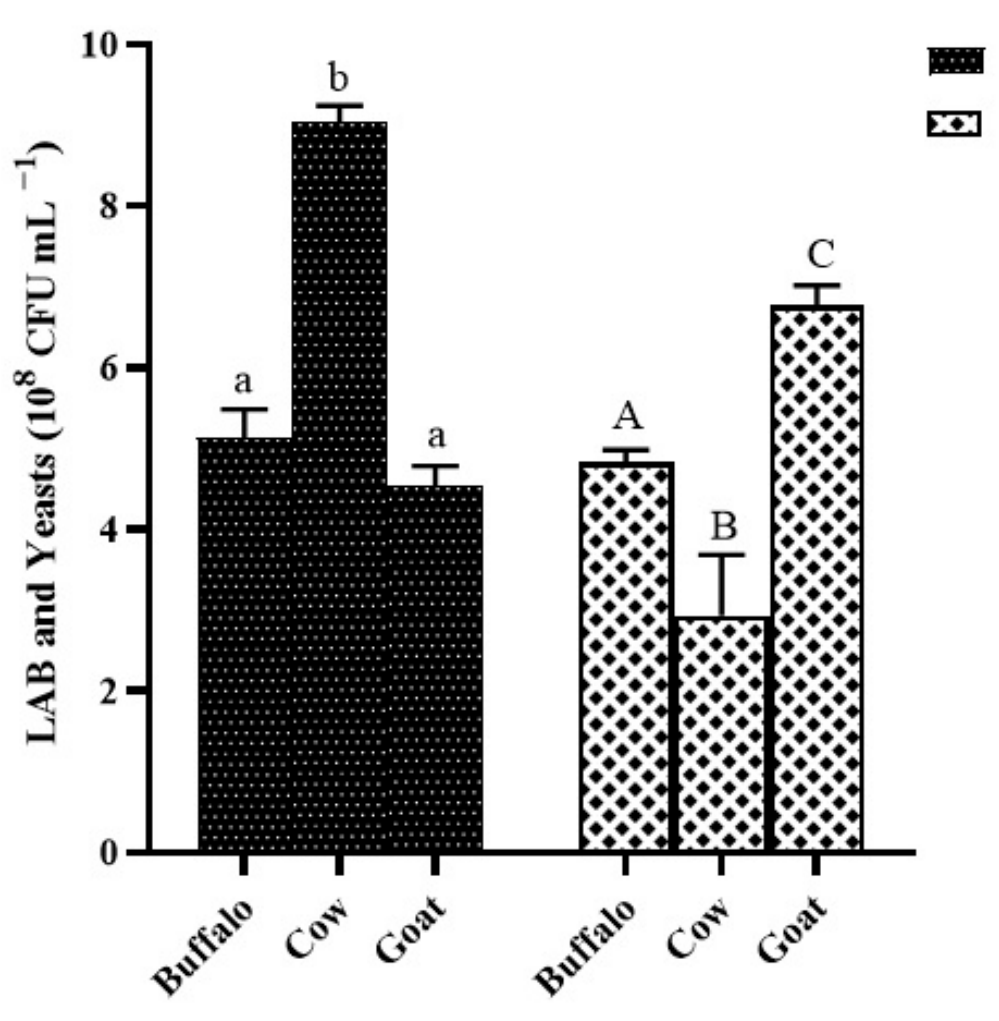
Figure 3. Cell counts of lactic acid bacteria and yeast populations in kefir grains from fermented buffalo, cow, and goat milk after 24 h. Histograms represent the averages of three independent experiments (each done in triplicate) and error bars indicate the standard deviation. Letters on histograms denote statistical analysis. Values with the same letter are not significantly different, values with different letters are significantly different ( LAB : buffalo vs. cow, **** p value < 0.0001, cow vs. goat, **** p value < 0.0001; Yeast : buffalo vs. cow, *** p value < 0.001, buffalo vs. goat, *** p value < 0.001, cow vs. goat, **** p value < 0.0001).